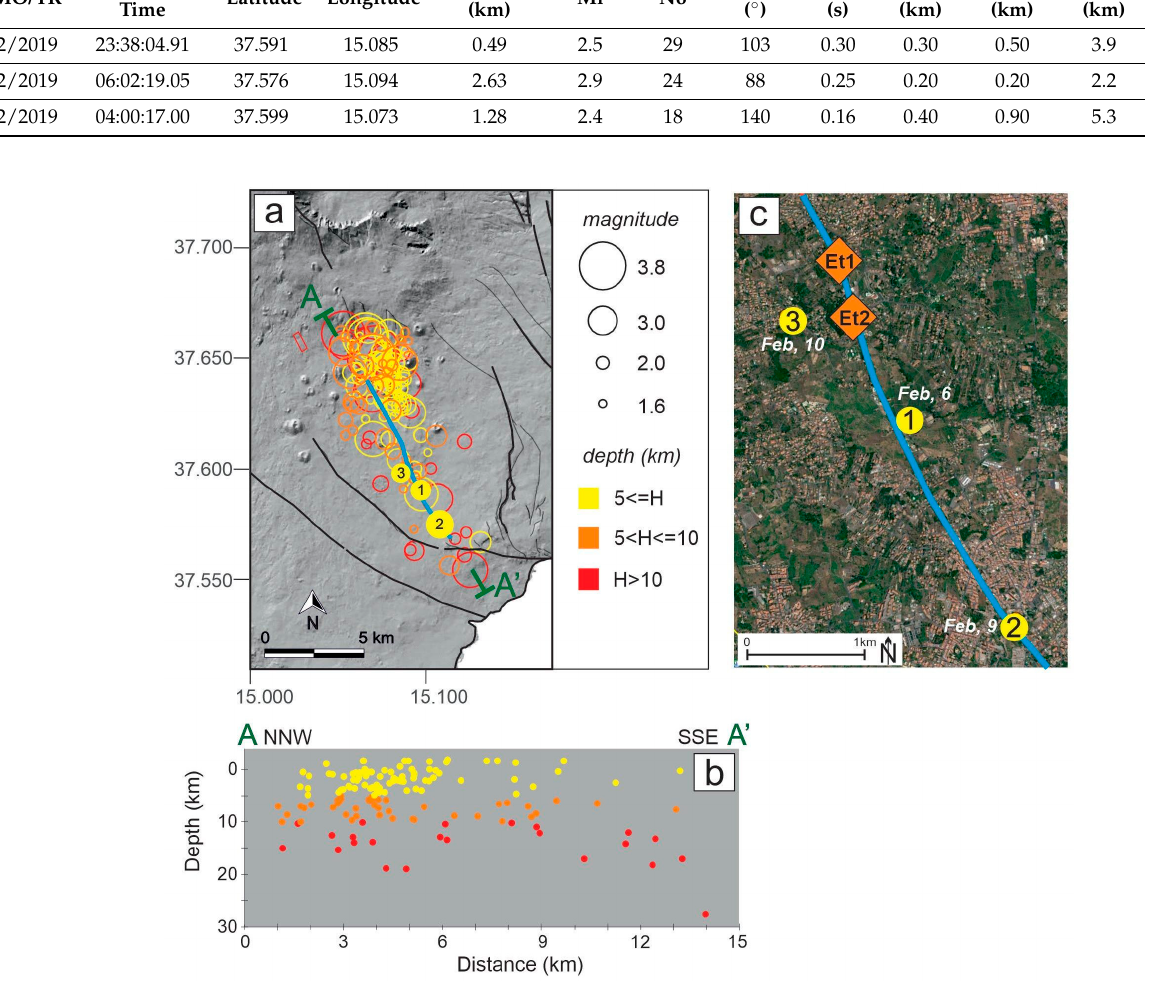
Figure 7. ( a ) Epicentral map of earthquakes belonging to C2.5 and CALL catalogues in the period 1980–April 2021. Coloured circles and their size indicate range depth and magnitude values, respectively; ( b ) cross ‐ section along TF in the NNW–SSE direction; ( c ) epicentral map of February 2019 seismicity (numbered yellow circles; see Table 1) and location of extensometer Et1, Et2 (red diamond); blue line: Trecastagni Fault.